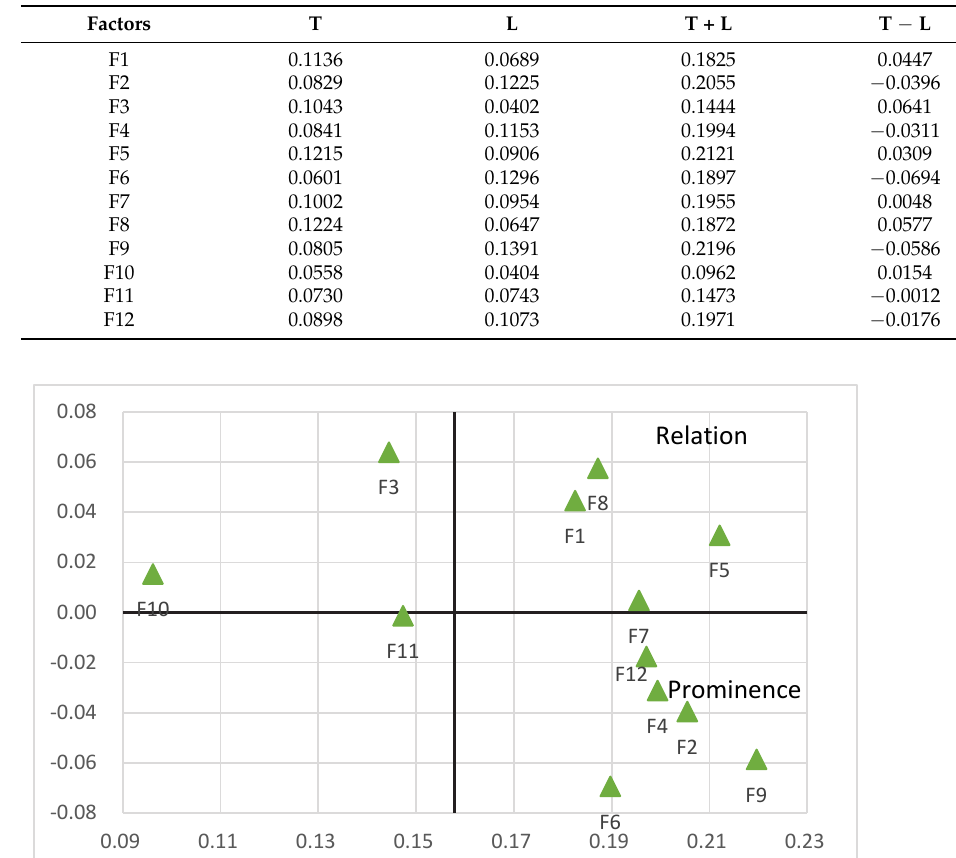
Figure 2. The cause − effect graph. Codes are the abbreviations of Factors.